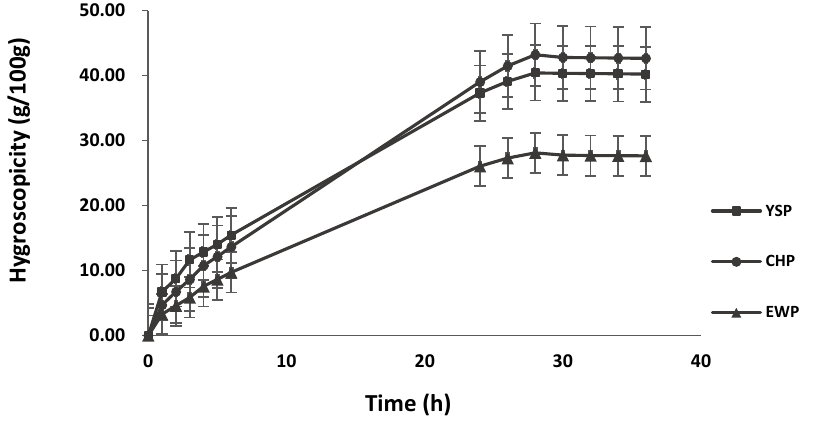
Figure 1. Hygroscopicity of yellow soybean powder (YSP), chickpea powder (CHP), and egg white powder (EWP) measured for 36 h. All values are expressed as mean ± standard deviation ( n = 3).